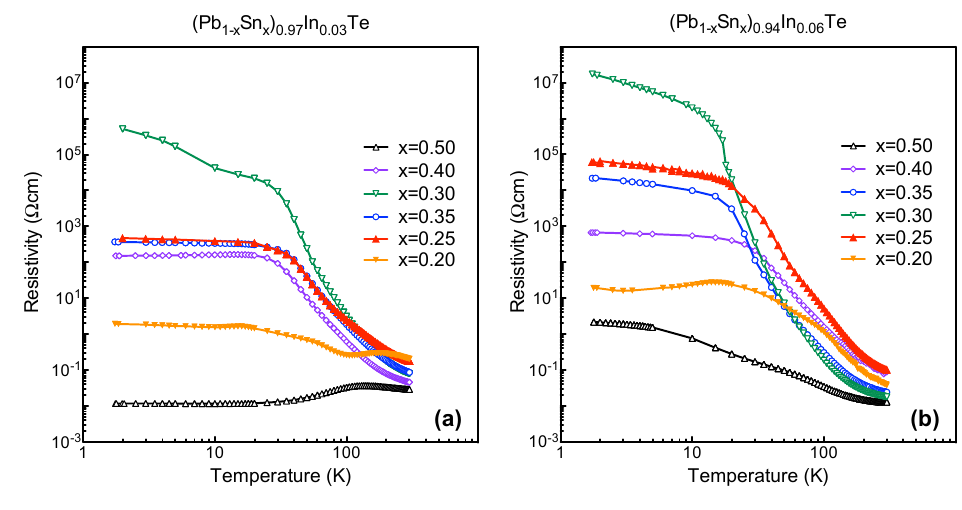
Figure 6. Temperature dependence of the resistivity for ( a ) (Pb 1 − x Sn x ) 0.97 In 0.03 Te and ( b ) (Pb 1 − x Sn x ) 0.94 In 0.06 Te single crystals. The resistivity values are shown in a logarithmic